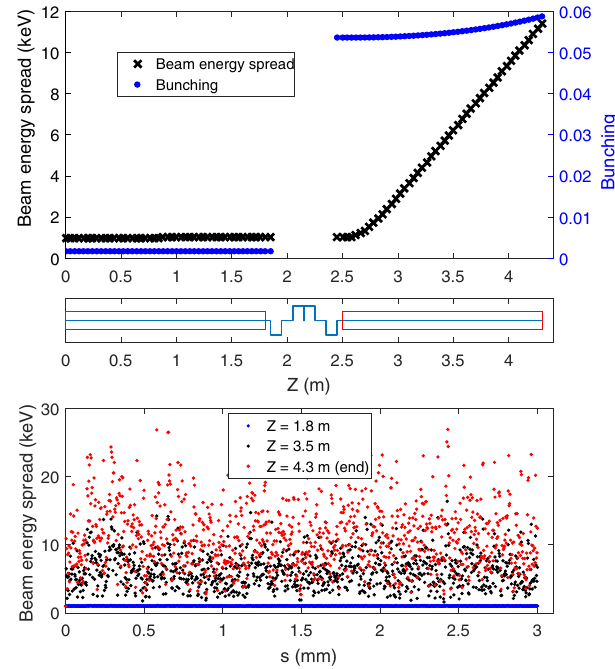
FIG. 2. Simulation results for an initial beam energy spread of 1 keVand a longitudinal dispersion of 10 mm. Top: average beam energy spread (black crosses, left axis) and bunching (blue dots, right axis) along the longitudinal position of the system. Bottom: beam energy spread along the longitudinal position of the bunch for three different locations: Z ¼ 1 . 8 m (before the chicane), Z ¼ 3 . 50 m, and Z ¼ 4 . 3 m (end ofthesecondundulator module).